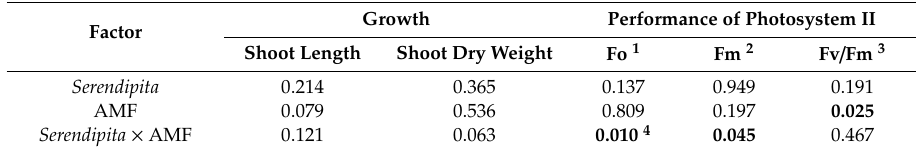
Table 2. Results of the two-way ANOVA ( p -values) for growth and photosynthetic performance in tomato plants nine weeks after transplanting with the factors ‘ Serendipita ’, ‘AMF,’ and ‘ Serendipita × AMF’ interactions ( p < 0.05, n = 15).